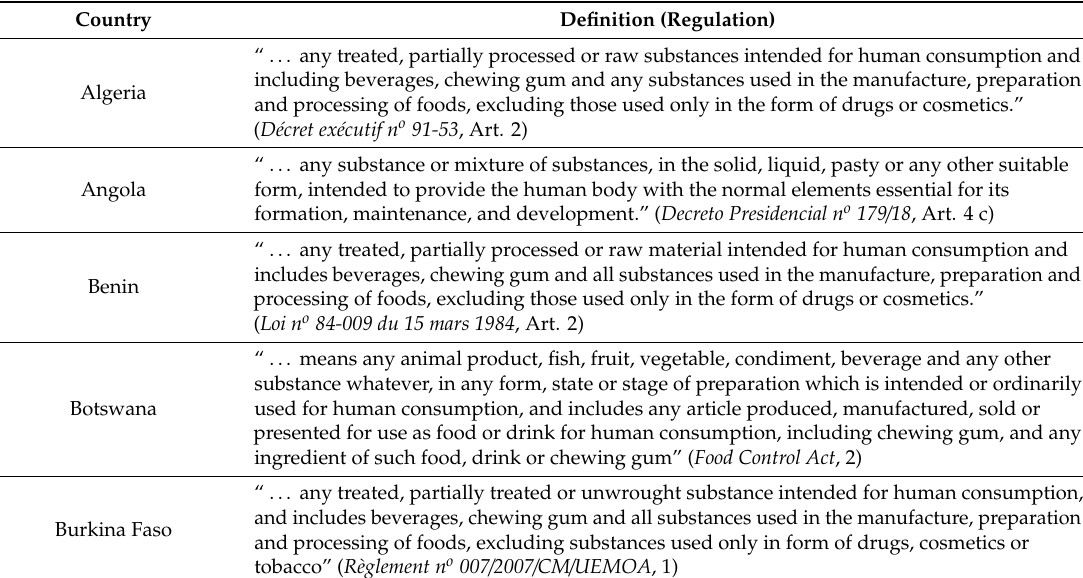
Table 4. Definitions of “foodstu ff ” in African food regulation frameworks; for Botswana, Burundi, Cameroon, Chad, Comoros, Congo-Brazzaville, Congo-Kinshasa, Djibouti, Equatorial Guinea, Eritrea, Gabon, Gambia, Guinea, Lesotho, Malawi, Mauritania, Libya, S ã o Tom é and Pr í ncipe, South